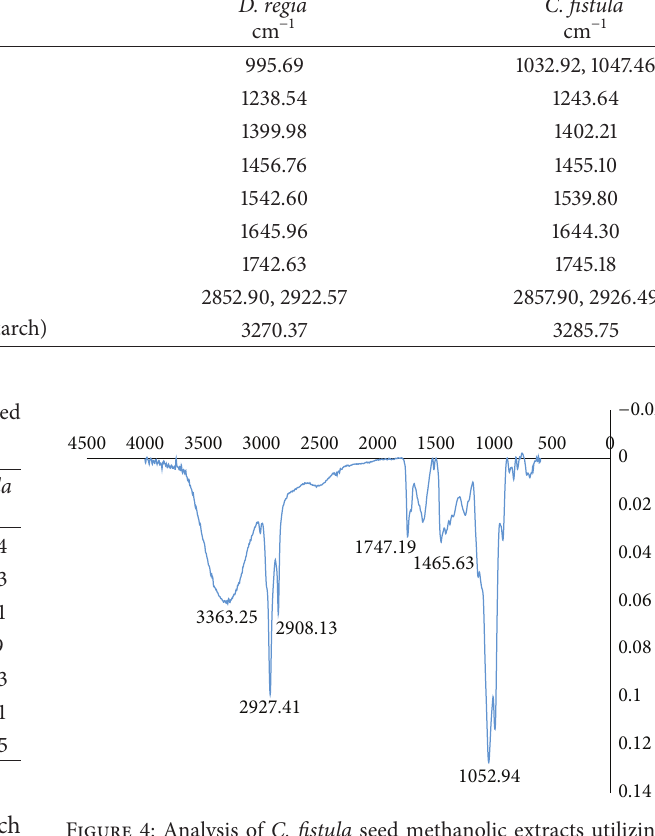
Figure 4: Analysis of C. fistula seed methanolic extracts utilizing